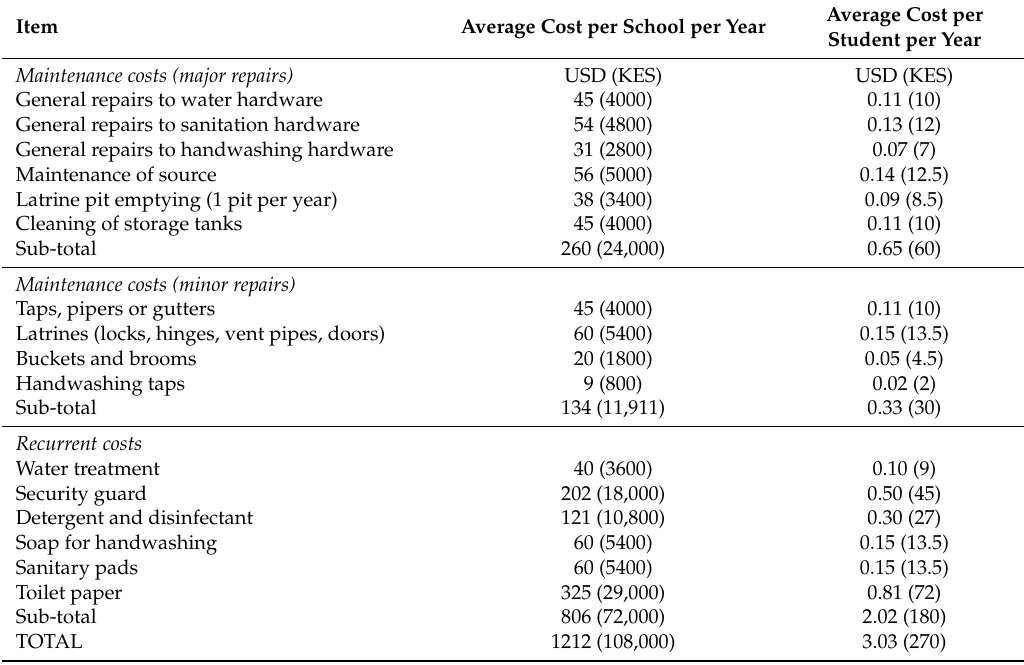
Table 5. Maintenance and recurrent costs per year for schools in Kenya,